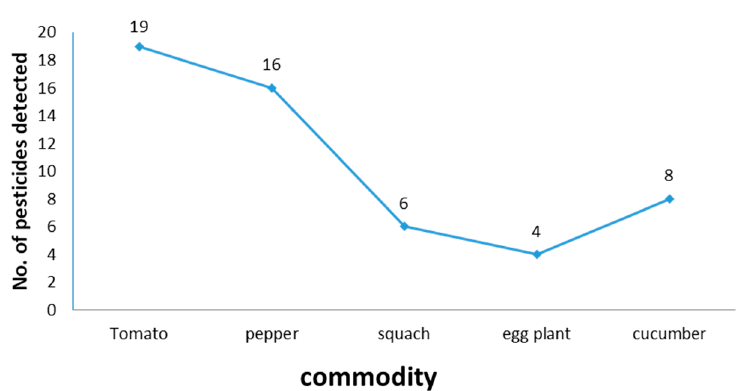
Figure 3. Demonstrates the contamination with pesticide residues. Table 1. Demonstrates the frequency of occurrence of pesticides.